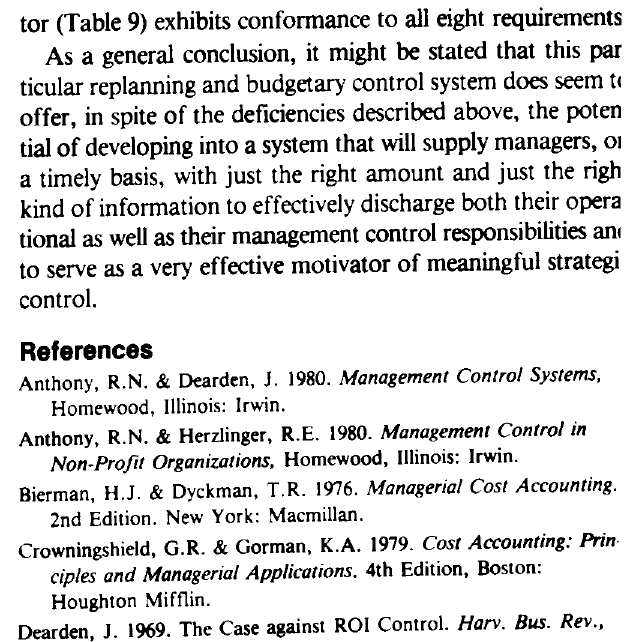
Table 10 Evaluation of budgetary control system